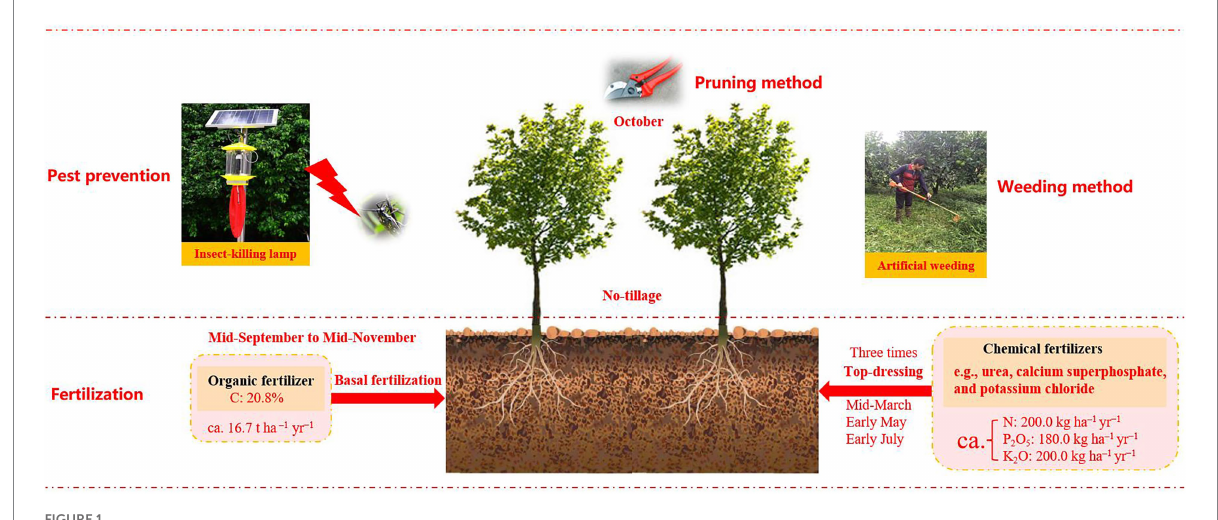
FIGURE 1 The agricultural management practices (e.g., fertilization, pest prevention and weeding method, etc.) in the present study (Luan et al.,